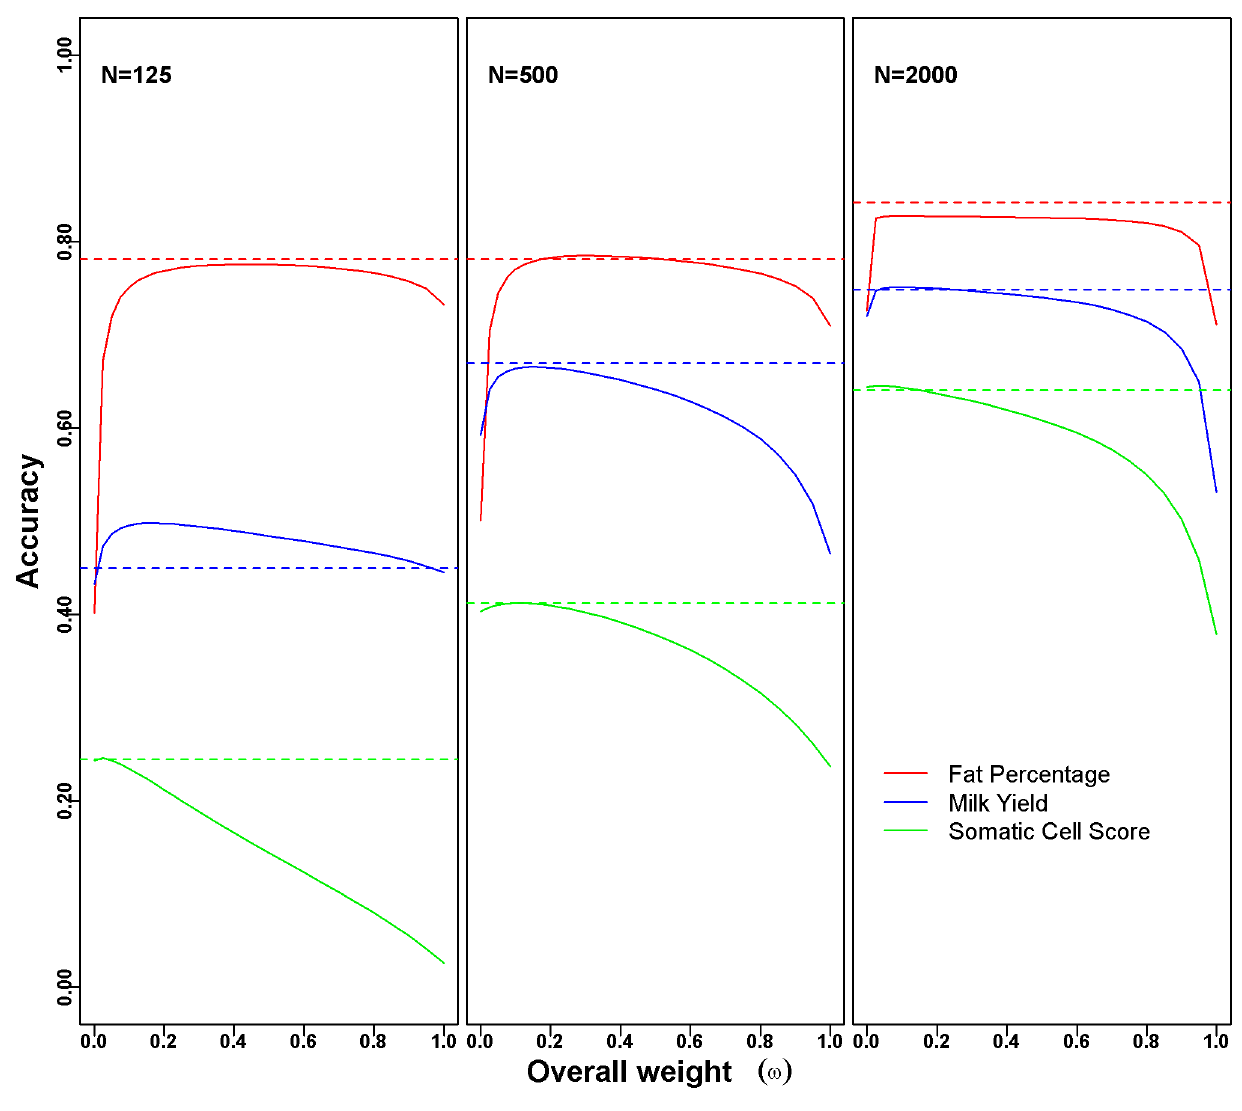
Figure 1. Accuracies of WGP in dairy cattle data set. The solid lines show the change of BLUP|GA accuracy with the overall weight ( v ) for fat percentage (red), milk yield (blue), and somatic cell score (green). SNP weights in the BLUP|GA approach were based on the number of QTL reports as described in the ‘Material and Methods’ section. GBLUP corresponds to the scenarios with overall weight v =0, and the accuracies of BayesB are presented by horizontal colored dash lines. Accuracies were calculated as the mean of 20 replicates of five-fold cross-validation with variable population size ( N =125, 500 and 2000).